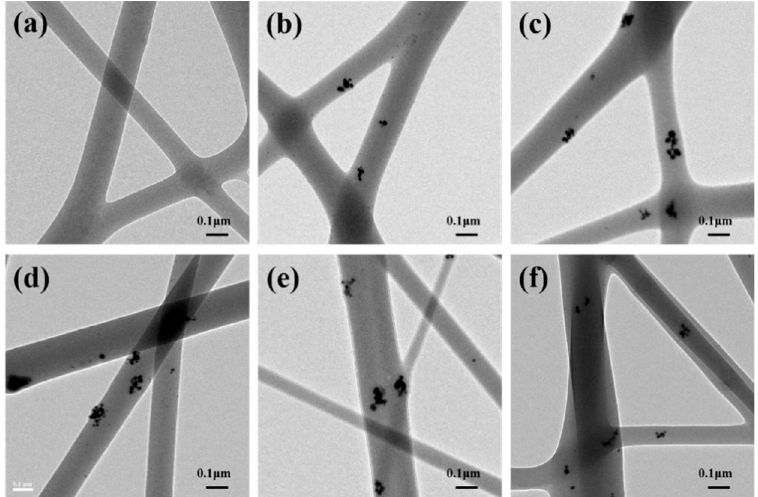
Figure 4. TEM images of FK/PVA/PEO composite nanofibers: ( a ) 0%-AgNPs, ( b ) 0.6%-AgNPs, ( c ) 1.2%-AgNPs, ( d ) 1.8%-AgNPs, ( e ) 2.4%-AgNPs, ( f ) 3.0%-AgNPs.